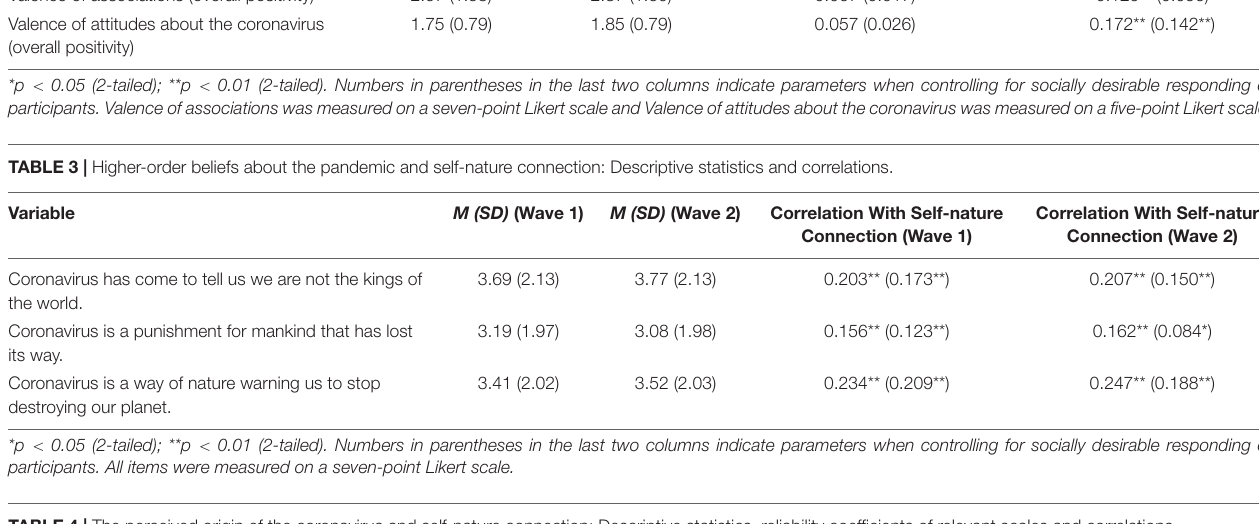
TABLE 2 | Valence of associations, valence of attitudes about the coronavirus and self-nature connection: Descriptive statistics and correlations. Variable